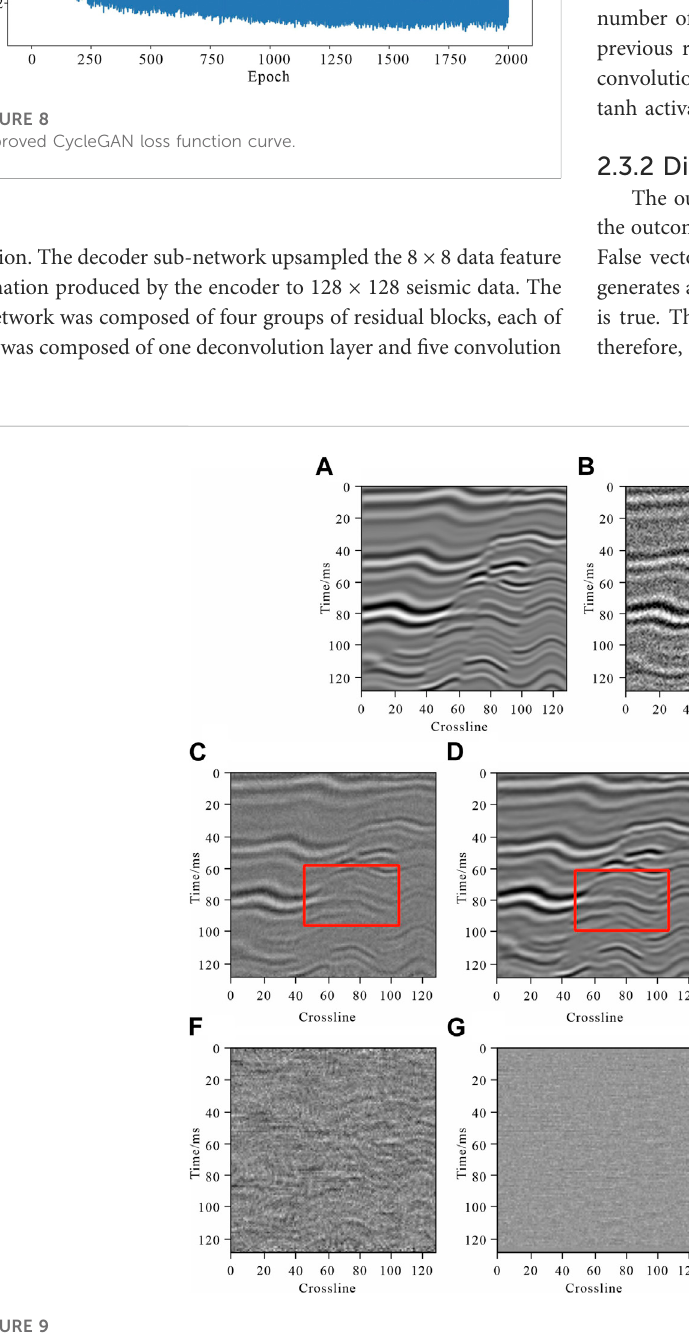
FIGURE 9 Experimental results for the model seismic data. (A) Original model data, (B) model data with random noise, (C) denoising effect of FX deconvolution method, (D) denoising effect of the original CycleGAN method, and (E) denoising effect of the improved CycleGAN method, (F) noise removal by FX deconvolution method, (G) noise removal by the original CycleGAN method, and (H) noise removal by the improved CycleGAN method developed